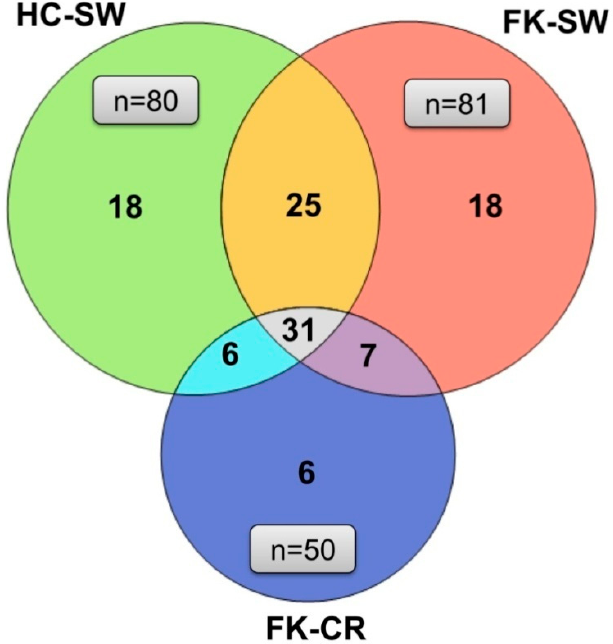
Figure 4. Venn diagram representing fungal genera present exclusively in each group (HC-SW, FK-SW, and FK-CR) and common between all three groups and two groups.